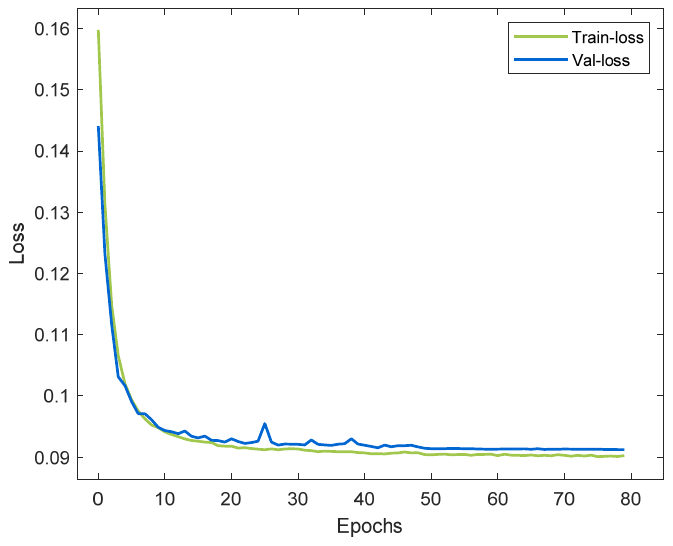
Figure 8. G-UNets loss value change curve.